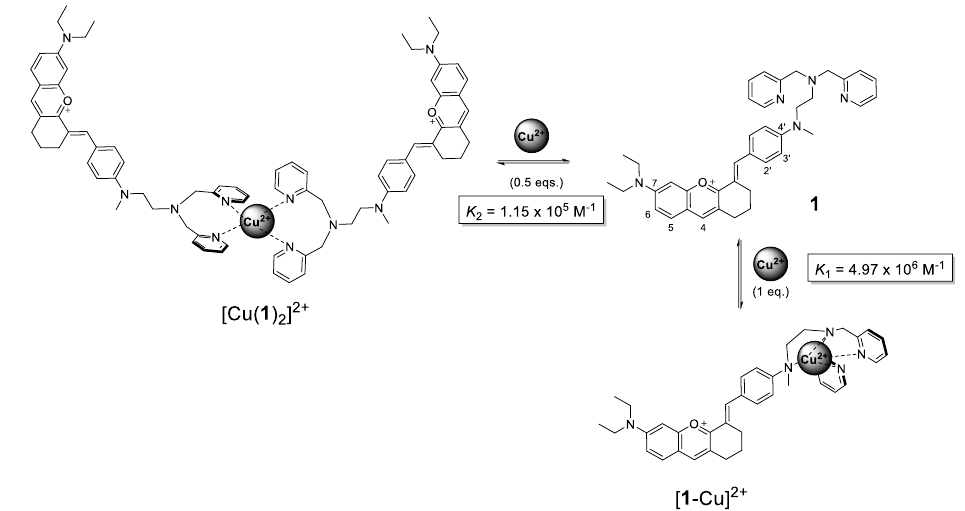
Scheme 1. Proposed mechanisms for the coordination of Cu(II) with chemosensor 1 .